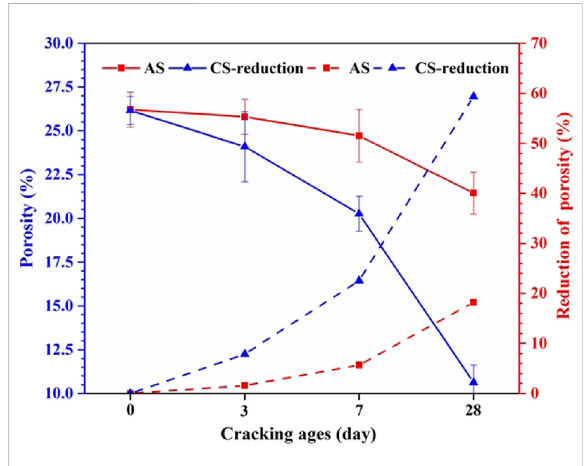
FIGURE 6 Results of the porosity test after self-healing of cement- based